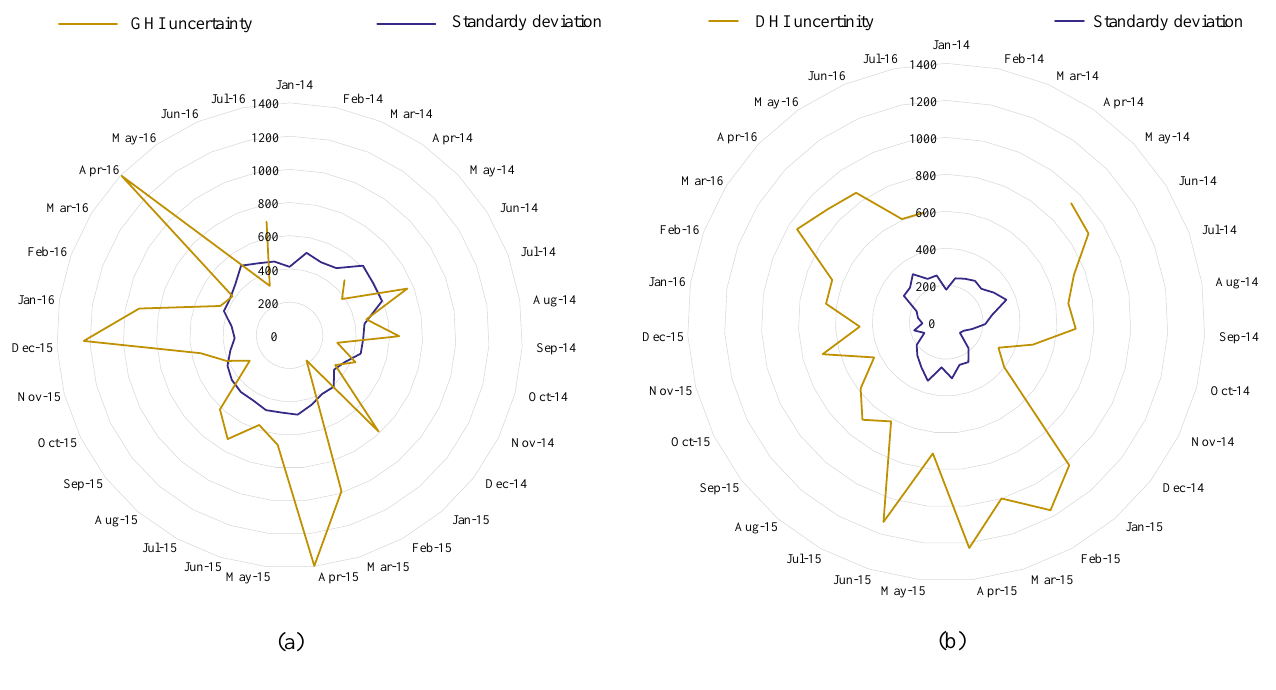
Figure 4. The standard deviation and uncertainty of the monthly ( a ) GHI ( b )